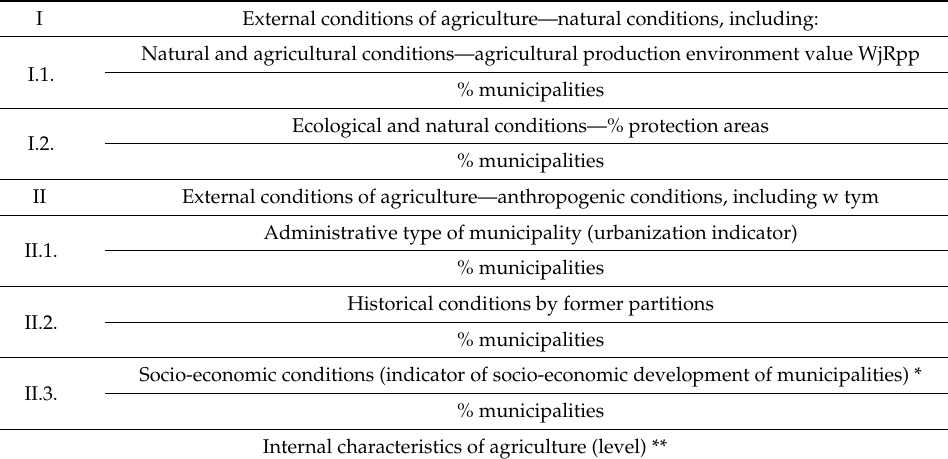
Table 2. Elements of evaluation of the spatial diversity in pro-environment activities of agricultural